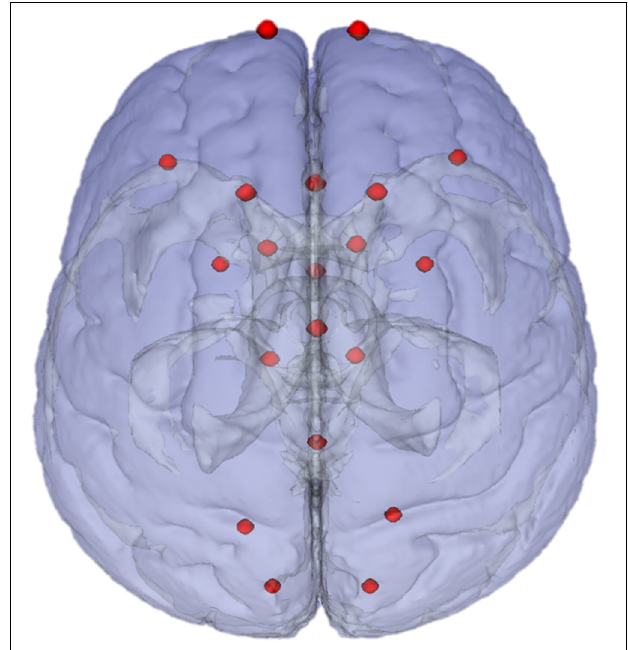
FIGURE 2 | Landmarks in ICBM2009a space. Chosen landmarks are a subset of 20 chosen from the landmarks recommended in Chollet et al. (2014).